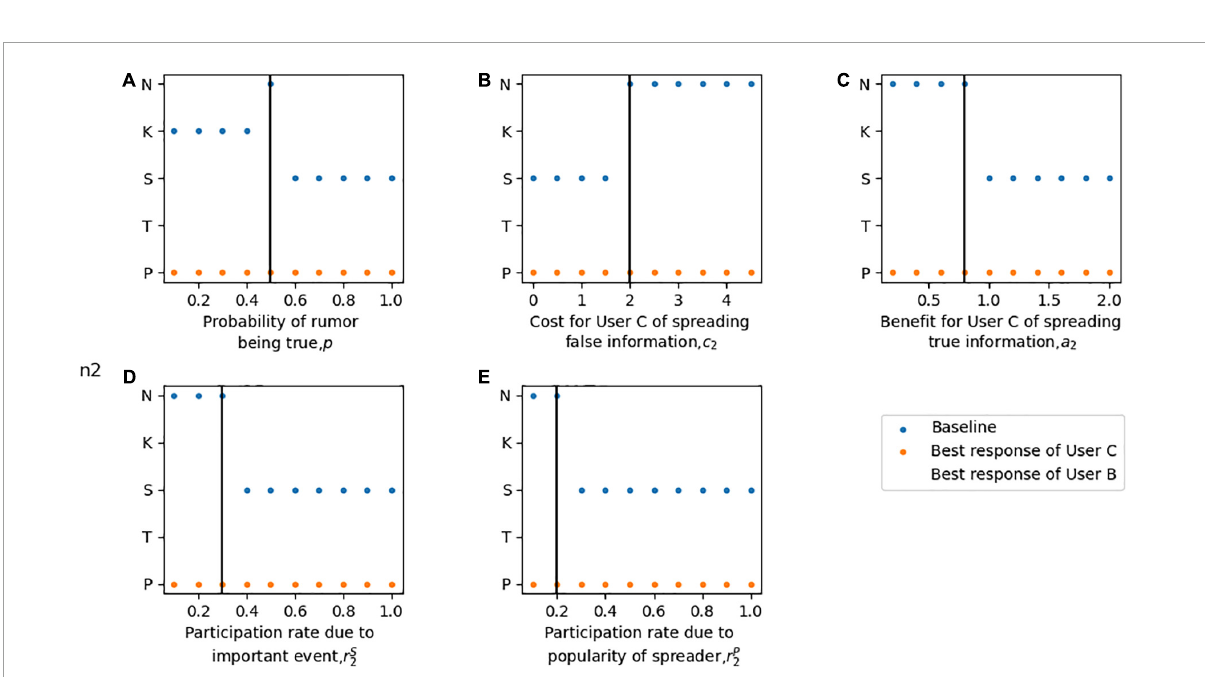
FIGURE3 The best response of Users B and C gave that User A disregards the rumor in the rumor clarification model. For part panel (A–E) , the x-axis represents the change of each parameter, the y-axis indicates the optimal choice of Users B and C with the change of parameters when given that User A chooses not to clarify rumors. Orange indicates the strategy P or T of User B. Blue indicates the strategy S, K or N of User C. The vertical bar indicates the baseline value of each